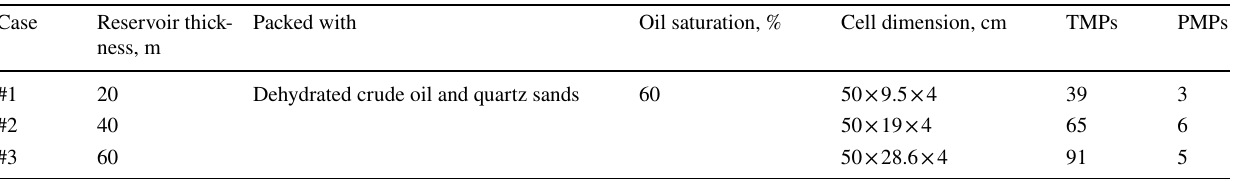
Table 2 Experimental parameters with different reservoir thickness Case Reservoir thick- ness, m